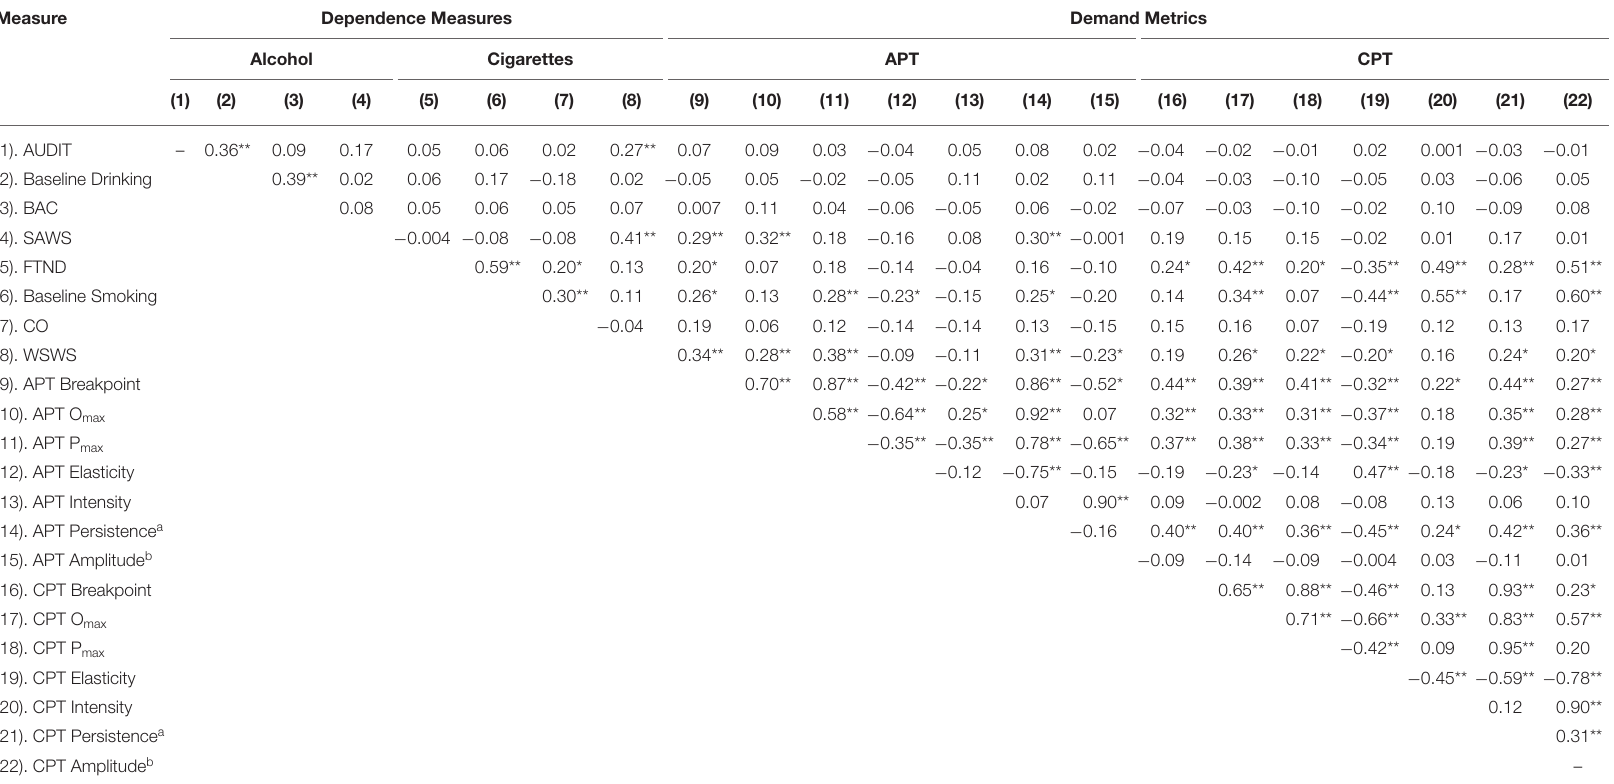
TABLE 4 | Bivariate correlations between demand metrics and dependence measures. Measure Dependence Measures Demand